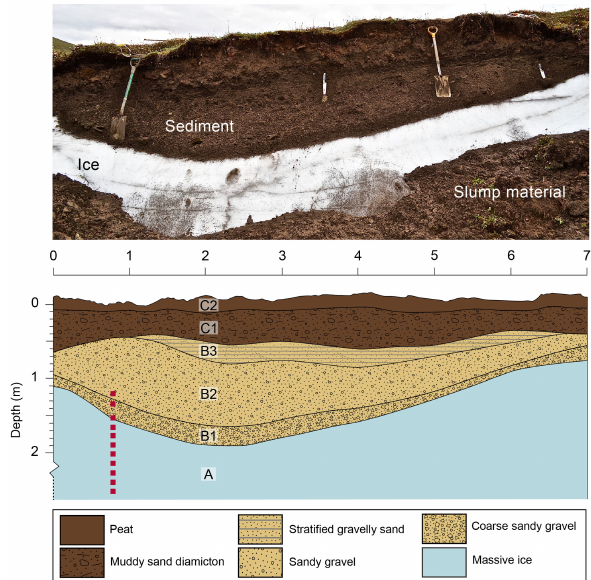
Figure 2. A photograph and a schematic cross section showing gen- eralized stratigraphy of the massive ice exposure and the overlying sediments. The lower and lateral contacts of the massive ice have not been reached. The thaw depths measured in late July (2013) at the headwall reaches 55cm. The red star indicates the sampling lo- cation of the organic material and the red dots show the sampling points for stable O-H isotope and